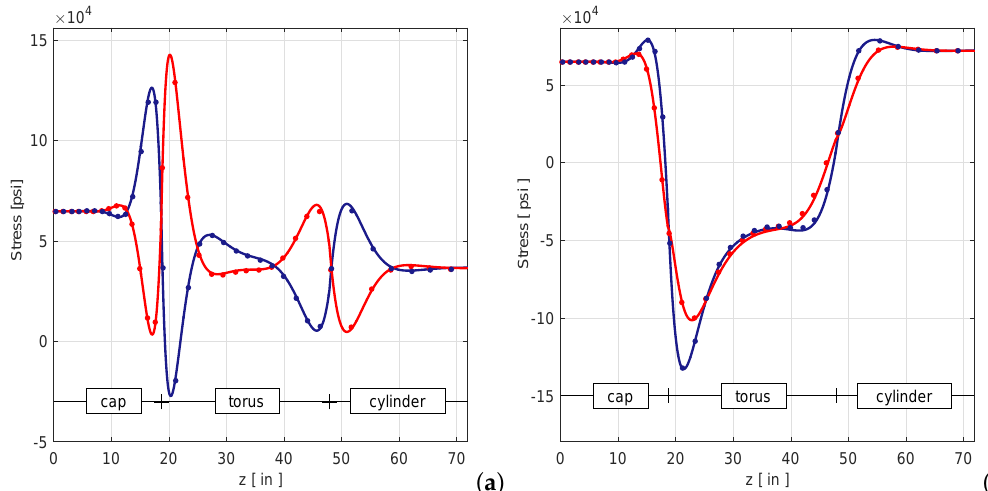
Figure 18. Torispherical tank subject to uniform internal pressure. ( a ) Axial normal stress σ 11 —inner ( ζ = − t /2) blue solid line -present approach vs. blue bullets— reference solution [59], outer ( ζ = t /2) red solid line—present approach vs. red bullets—reference solution [59]. ( b ) Circumferential normal stress σ 22 —inner ( ζ = − t /2) blue solid line—present approach vs. blue bullets— reference solution [59], outer ( ζ = t /2) red solid line - present approach vs. red bullets—reference solution